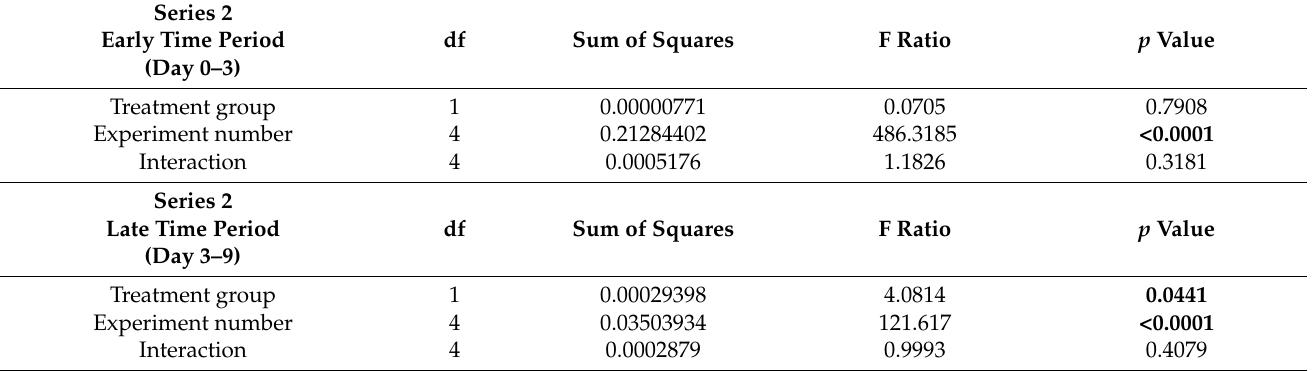
Table 5. Statistical analysis of experimental series 2. Results of two-way ANOVA of series 2 for numerically pooled treatment groups (As 2 O 3 17x–18x, 21x–23x, 28x, 30x, and 33x) and numerically pooled control groups (unsuccussed and succussed water) for n = 5 independent experiments in the early (day 0–3) and late time period (day 3–9). df—degree of freedom. Significant values